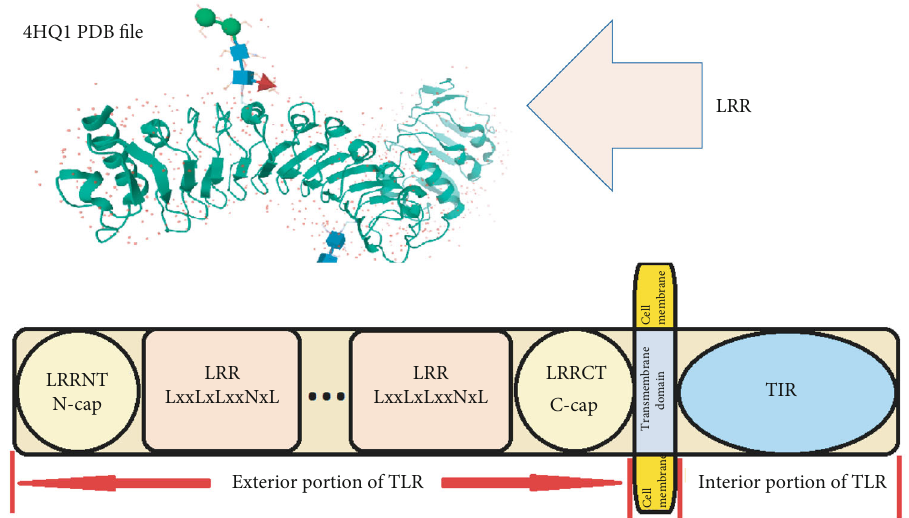
Figure 3: The structure of TLR and the related domains. The Ls in LxxLxLxxNxL depict hydrophobic core built of β -strands, and the N depicts the Asparagine network. The two-solenoid LRR structure shows the 3D structure of loops, helices (convex surface), and β -strands (concave surface) (4HQ1 PDB fi le)